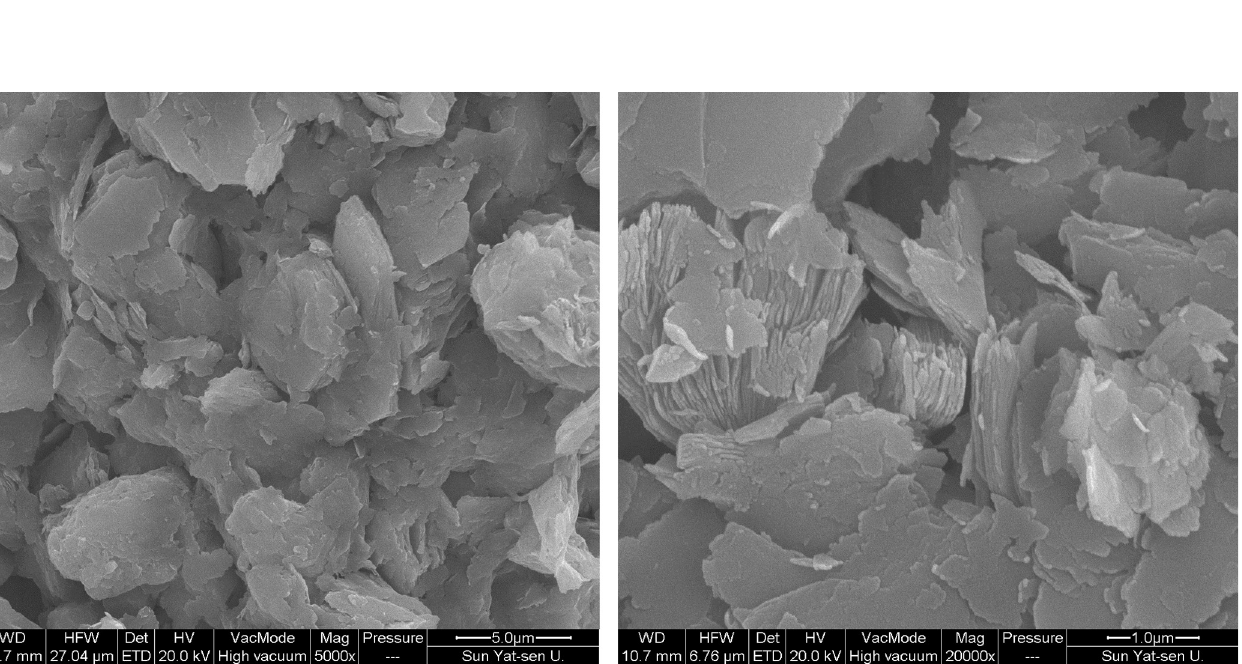
PLOS ONE | https://doi.org/10.1371/journal.pone.0275867 October 10, 2022 4 /